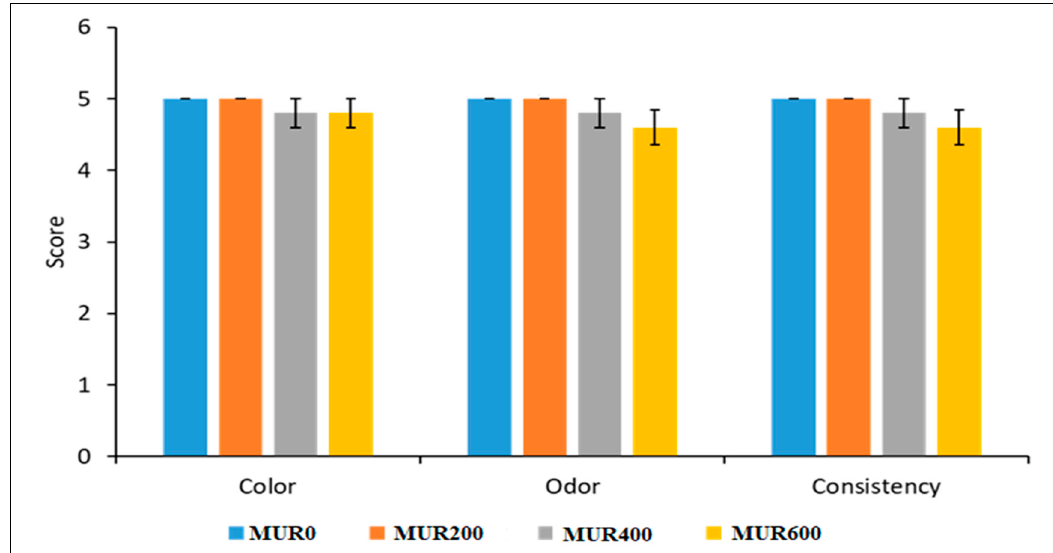
Figure 1. The effect of MUR on the sensory characteristics of the broiler carcasses. Values represent mean ± SE of the scores of the five panelists. Bars without superscripts are not significantly different (Tukey’s test, p > 0.05). Table 3. Effect of MUR on the color and texture of breast muscles. Traits